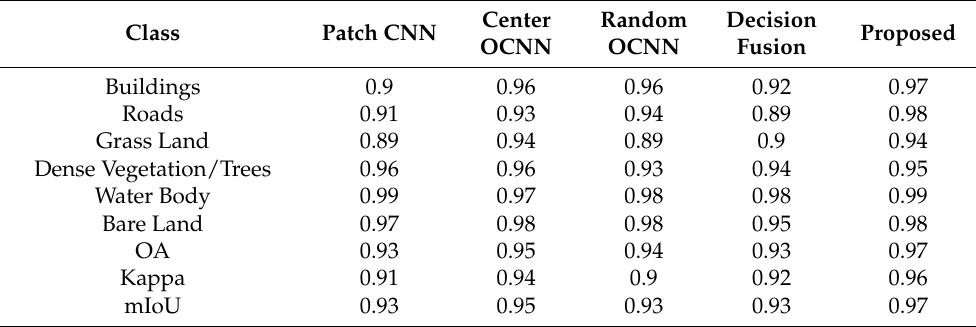
Table 6. Overall accuracy and per-class accuracies of the proposed and benchmark classification methods based on samples from the test area.